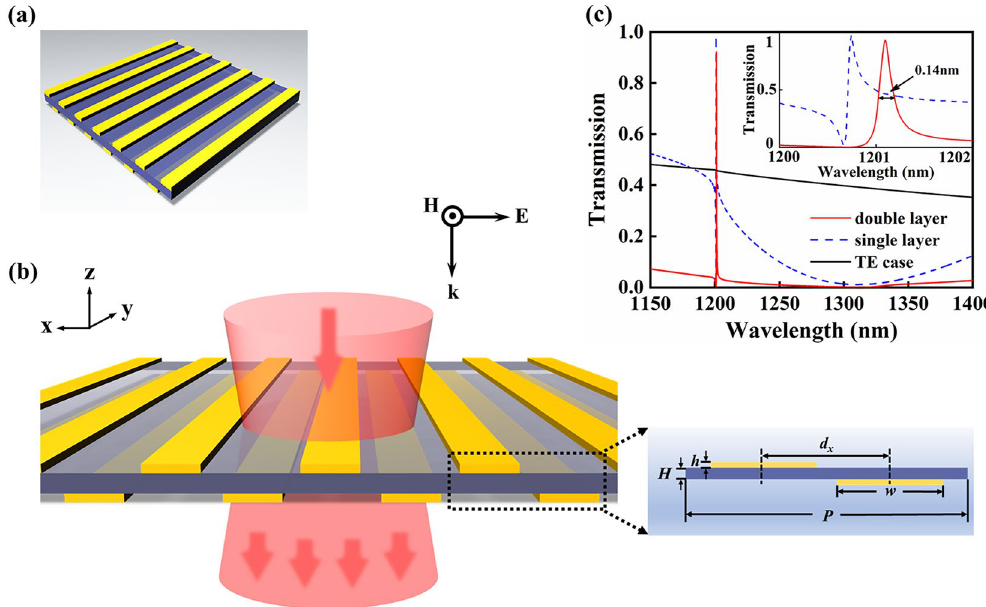
Figure 1. Freestanding bilayer plasmonic waveguide structure and its representative optical characteristics. ( a ) Three-dimensional schematics of the proposed plasmonic nanostructure consisting of two identical gold nanowire gratings separated by a finite dielectric waveguide and a lateral shift between them. ( b ) Front view of the proposed nanostructure. Inset shows the cross section of a structure unit cell with geometric dimensions specified. ( c ) The transmission (red solid line) spectrum for the plasmonic waveguide structure with waveguide thickness H = 20 nm and the lateral shifts d x = 550 nm. As a contrast, the transmission spectrum (blue dashed line) of single nanowire grating and waveguide structure is also shown for TM polarization and normal light incidence. In addition, transmission spectrum of double layer structure for TE polarization is also illustrated by black solid line. Inset shows a magnified view of transmission band for above two structures, in which the bandwidth and spectral features of transmission peak are